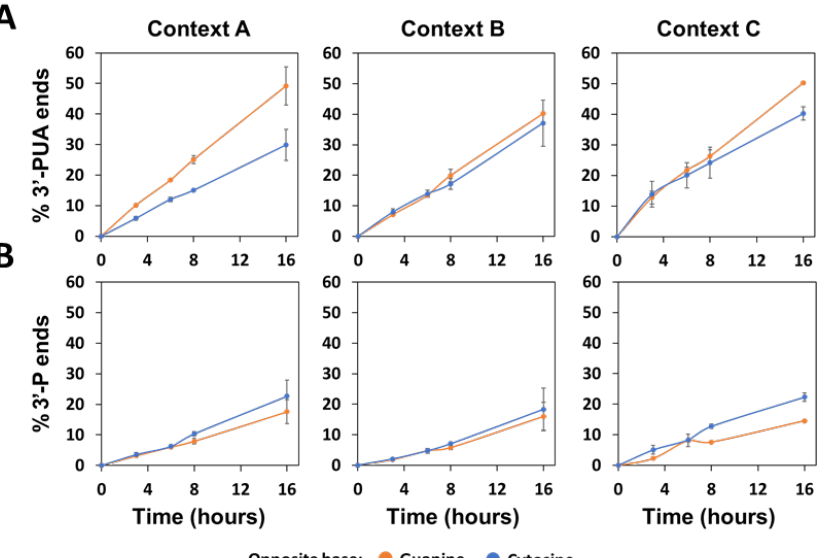
Figure 9. Effect of sequence context and base opposite the abasic site on the native AP lyase activity detected in human cells. Extracts from U2OS cells (20 μg) were incubated at 37 °C with 20 nM DNA substrates (context A, B or C) containing an AP site opposite guanine (orange) or cytosine (blue). After stabilization with NaBH 4 , the reaction products were separated denaturing PAGE, detected by fluorescence scanning and quantified. Graphs show percentage of incised products with 3 (cid:48) -PUA ends ( A ) or 3 (cid:48) -P ends ( B ). Data are the mean and standard error from three independent